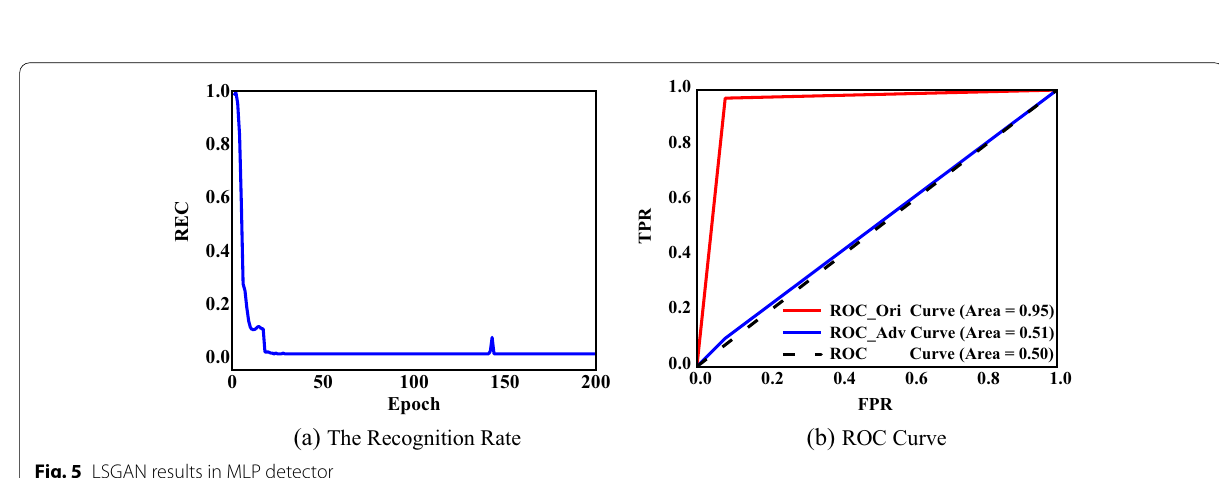
Fig. 5 LSGAN results in MLP detector